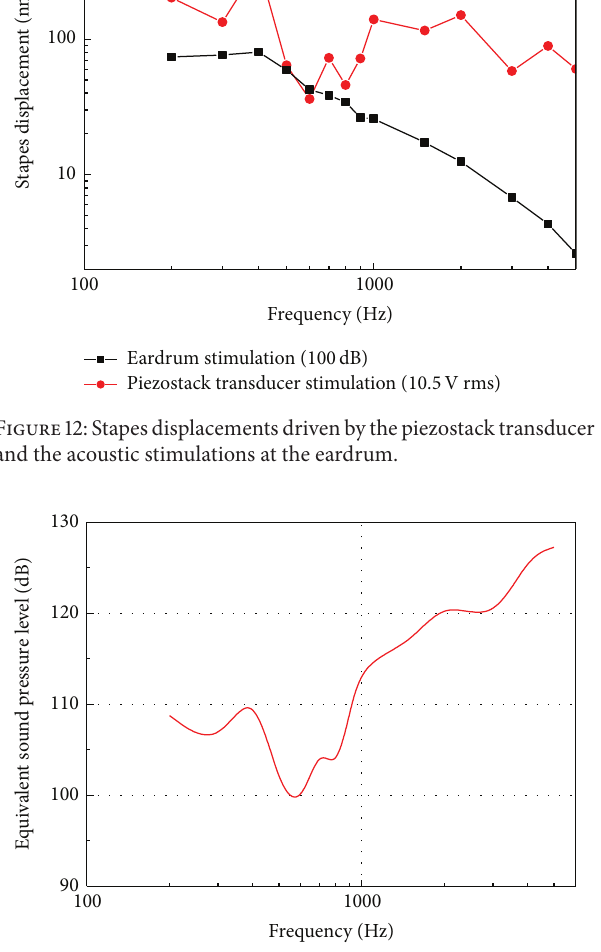
Figure 13: Equivalent sound pressure levels at the tympanic mem- brane for the transducer excitation at 10.5 V